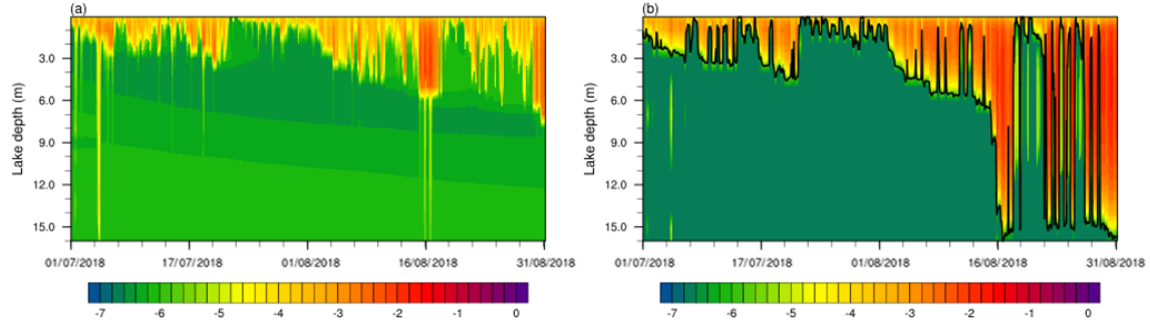
Figure 4. Simulated (a) log 10 K ORG w with CLM-ORG, and (b) log 10 K KPP w with CLM-KPP (unit: m 2 s − 1 ). The black line in (b) shows the lake boundary layer depth (unit: